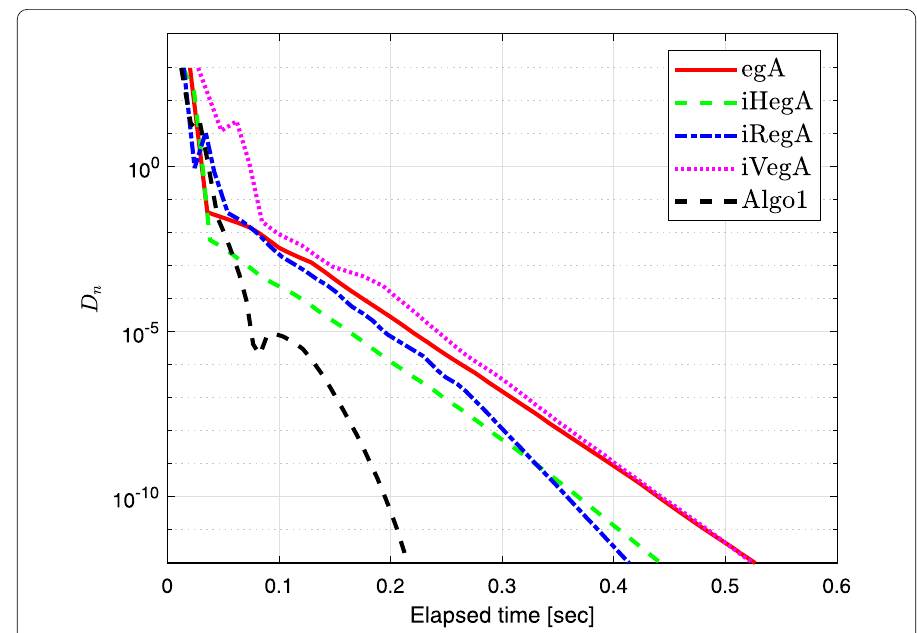
Figure 6 Example 5.2 when x 0 = 1: the number of iterations is 72, 65, 55, 44, 56, respectively